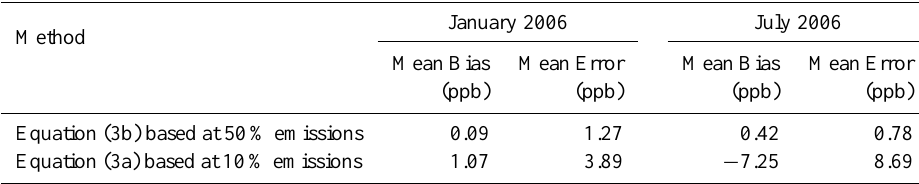
Table 1. Statistical comparison of two methods for predicting ozone with 25% anthropogenic NO x (100% VOC) emissions in 22 cities: (1) Eq. (3b) based at 50% emissions versus (2) Eq. (3a) based at 10% anthropogenic emissions.